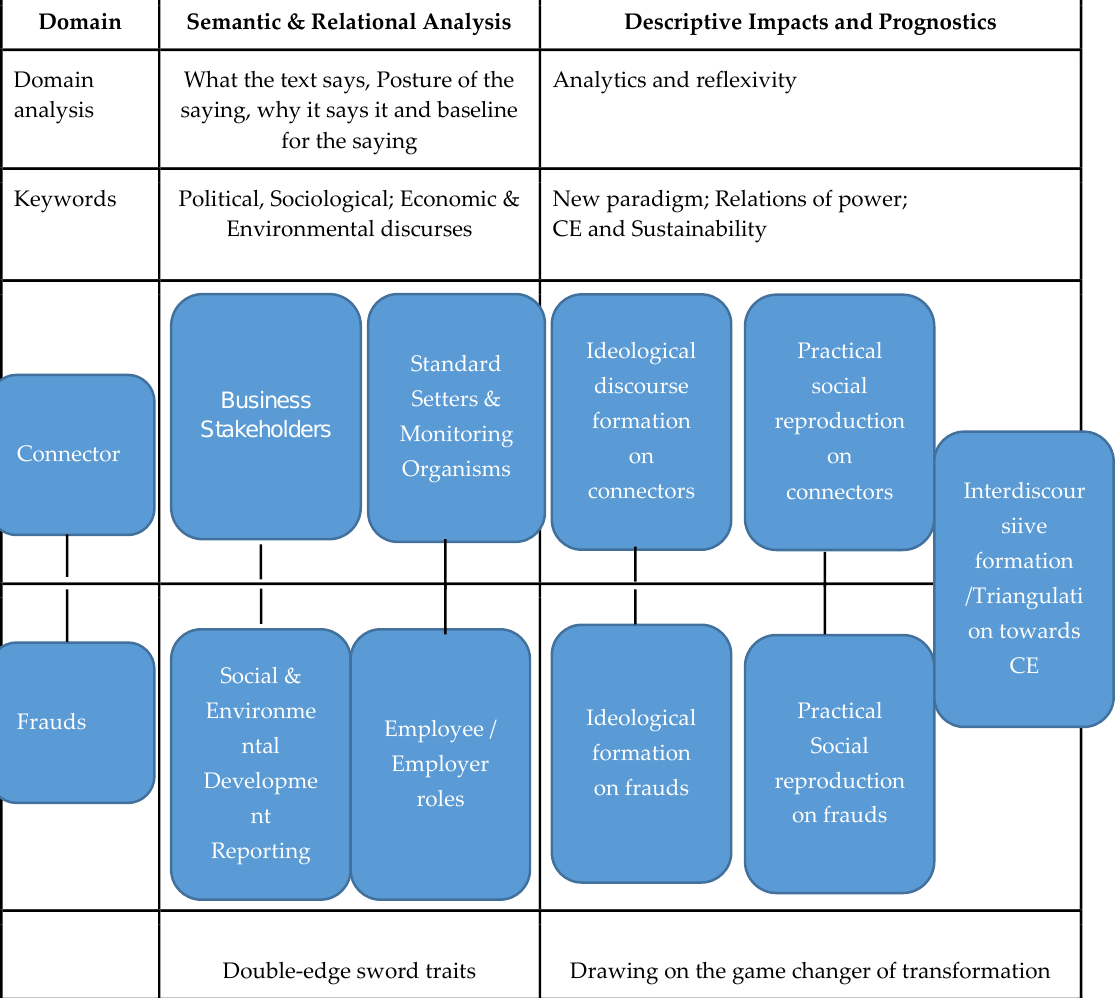
Figure 1. Approach on discourse analysis.